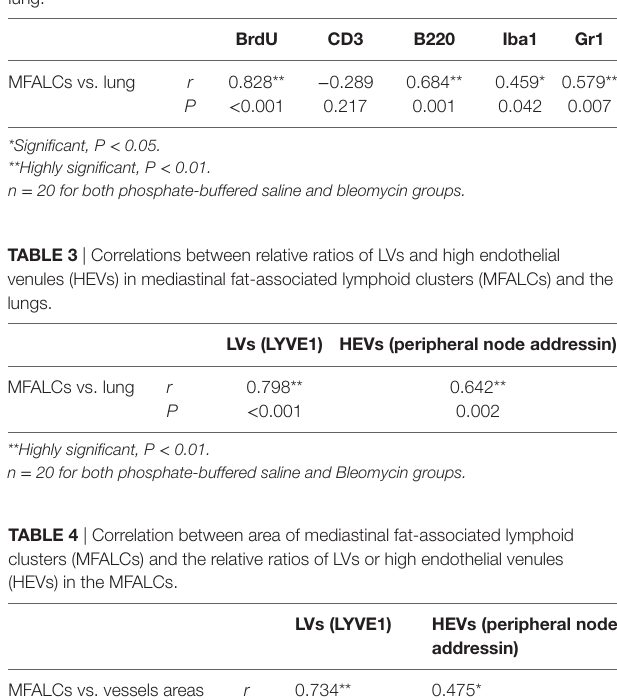
TaBle 2 | Correlations between density of immune-positive cells in the mediastinal fat-associated lymphoid clusters (MFALCs) and their numbers in the lung. BrdU cD3 B220 iba1 gr1 MFALCs vs. lung